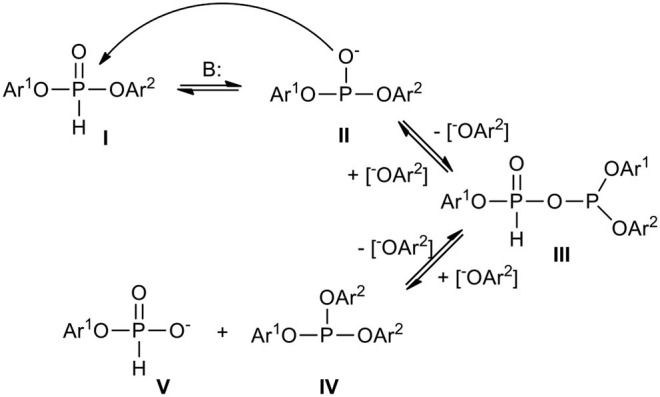
Scheme of structural phosphonate-phosphite disproportionation of an exemplary diaryl H-phosphonate.